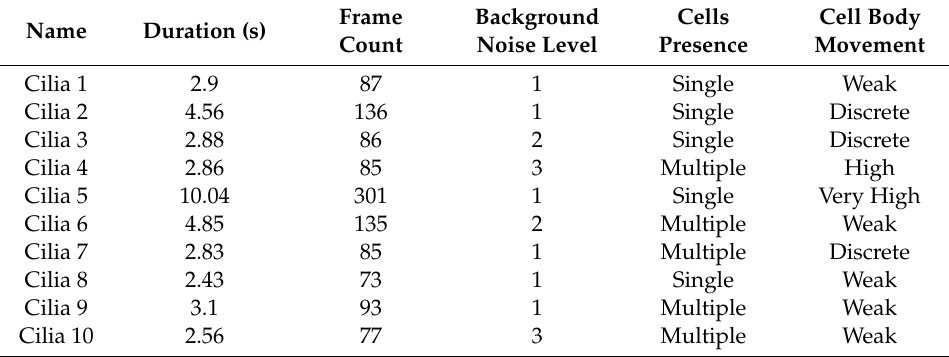
Table 1. Recap of the dataset with evidence of the different scenarios involved.